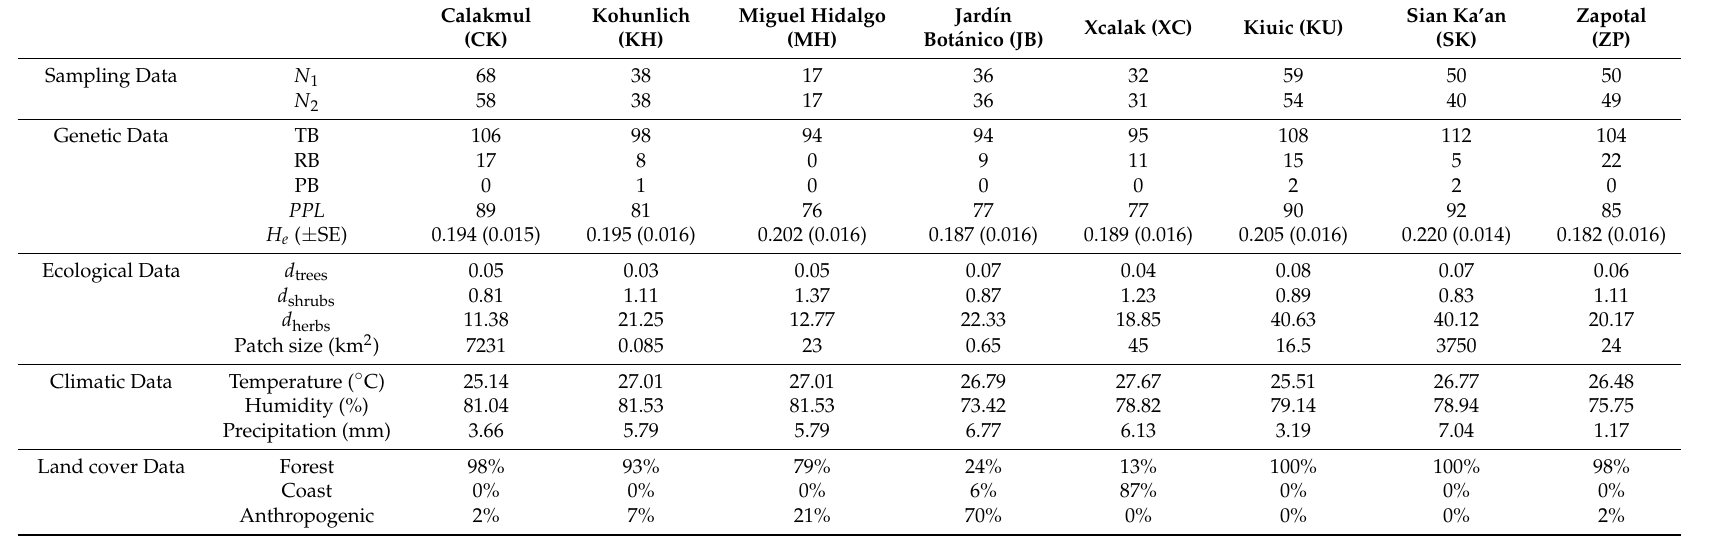
Table 1. Ecological, climatic, land use characteristics and genetic information (based on Inter Simple Sequence Repeats (ISSR) markers) obtained at each area for Eunica tatila in the Yucatan Peninsula, Mexico. Tree density ( d trees ), shrub density ( d shrubs ), density of herbaceous plants ( d herbs ), sample size ( N 1 ), number of individuals used for analysis ( N 2 ), total number of bands scored over all loci (TB), number of rare bands or bands with frequency ≤ 5% (RB), number of private bands or bands that exist only in this population (PB), percentage of polymorphism loci ( PPL ), expected heterozygosity ( H e ), standard error (SE), and land cover data (forest/coast/anthropogenic) represent the percentage of occupancy of each kind of land cover considered in this study within a 16 km 2 square surrounding each sampling point as shown in Figure